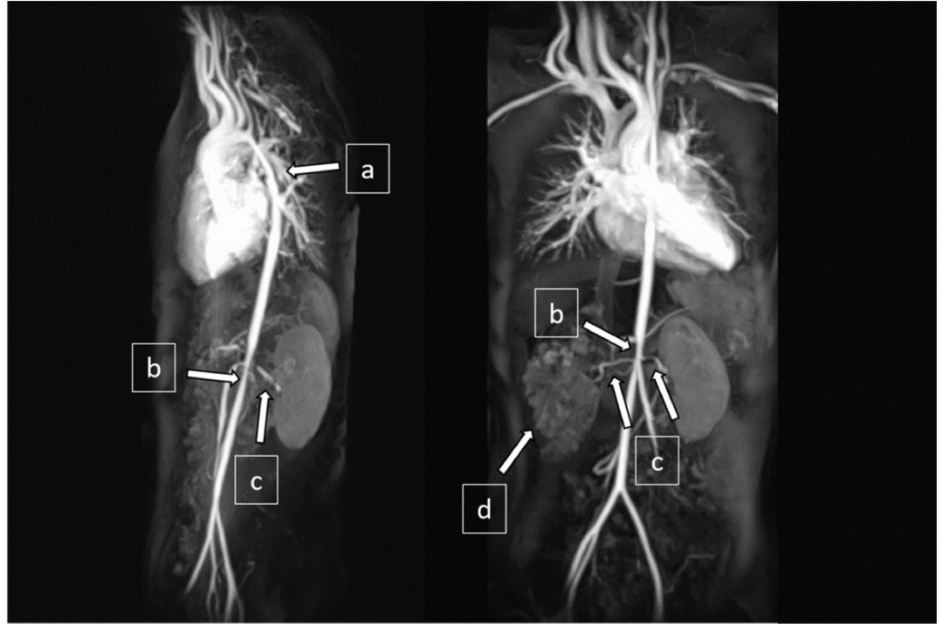
Figure 3. Magnetic resonance angiography (MRA) showed ( a ) narrowing at the distal aortic arch and descending thoracic aorta, ( b ) narrowing at the abdominal aorta, ( c ) bilateral renal artery stenoses, and ( d ) right cystic